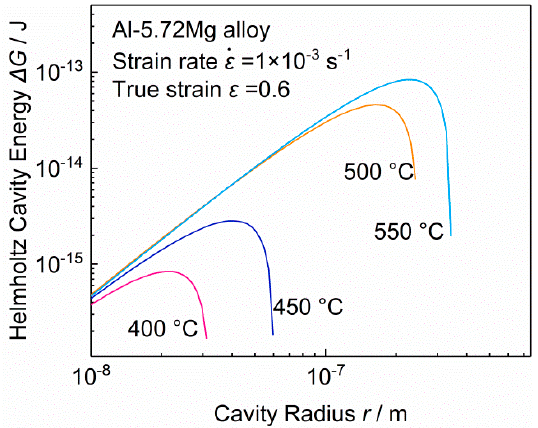
Figure 3. The relationship between the nucleation free energy and cavity radius of 5A70 aluminum alloy in the superplastic tensile state (400–550 °C).